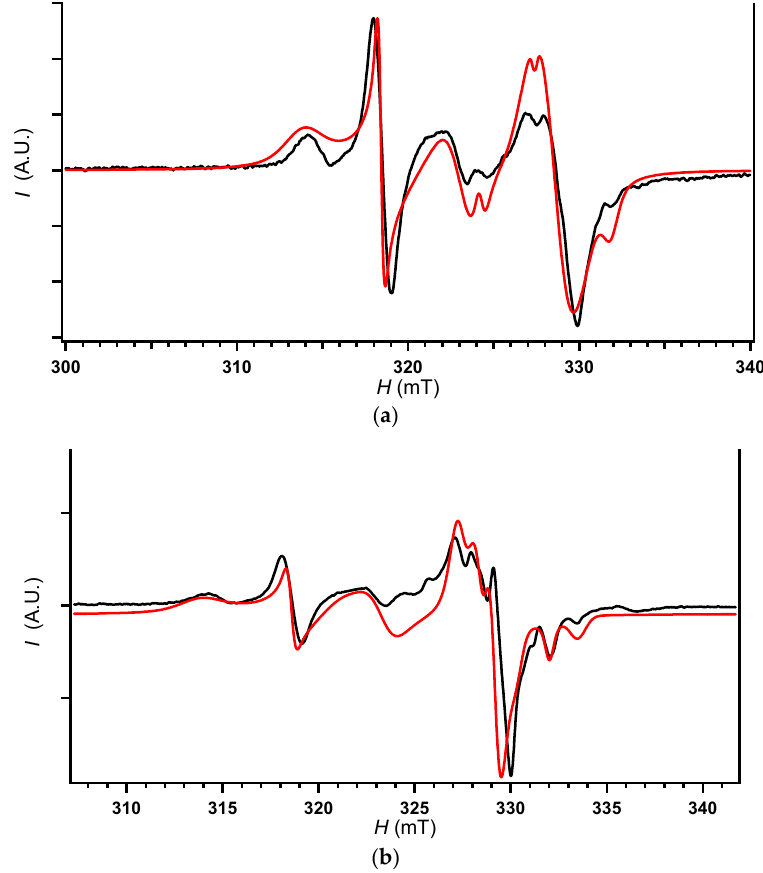
Figure 6. ESR spectra of δ‐ salt measured under dark and irradiated (254–450 nm) conditions. Black; observed, red; simulated spectra: ( a ) spectrum under dark condition and its simulated spectrum; ( b ) spectrum under irradiated condition and its simulated spectrum.